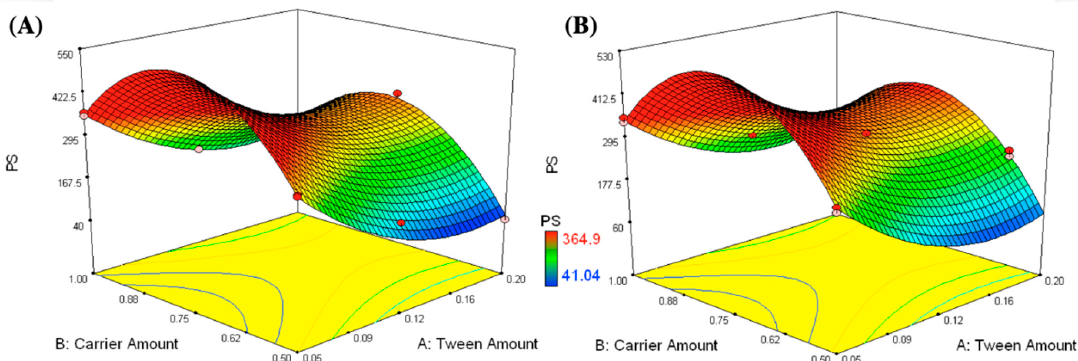
Figure 1. Response surface plots for the effects of T80 (X 1 ) and carrier amounts (X 2 ) on the mean particle size of the IFN formulations loaded on different types of carriers (X 3 ); mannitol ( A ) and Aerosil ( B ).